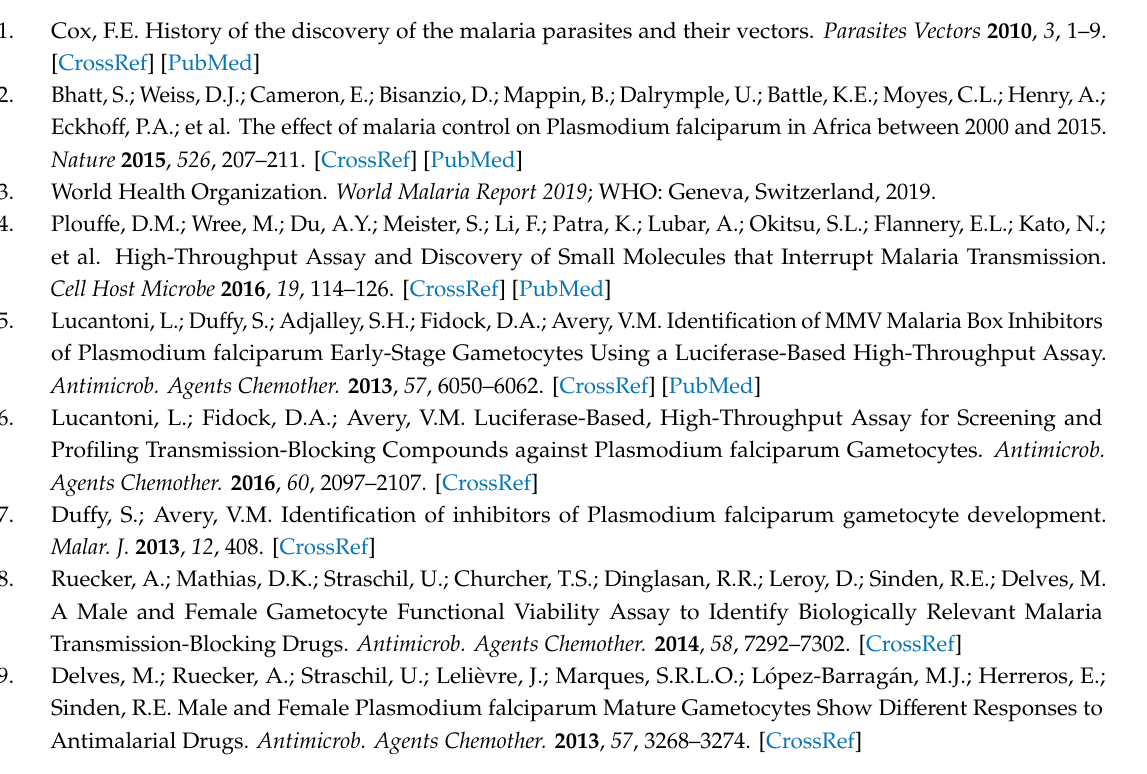
Table S1: Supplementary